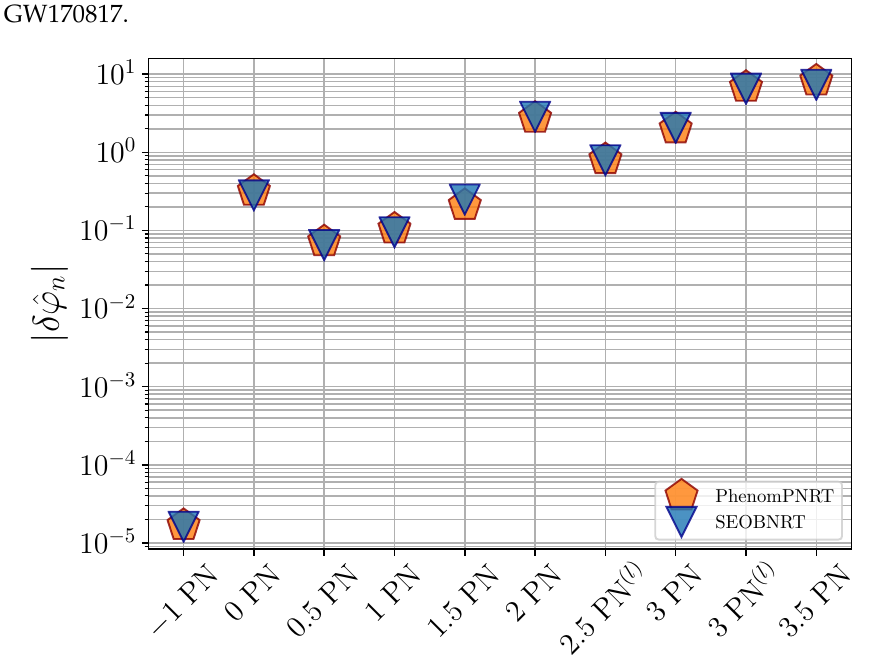
Figure 18. Bounds on deviation from phasing post-Newtonian coefficients from the analysis of the GW170817 signal. Note that the 1 and the 0.5PN coefficients are identically zero in GR. − Results for two different phenomenological approximants IMRPhenomP [58] and SEOBNR [59] are reported. Different approximants are obtained by resumming the PN approximation in different ways. From Abbott et al.